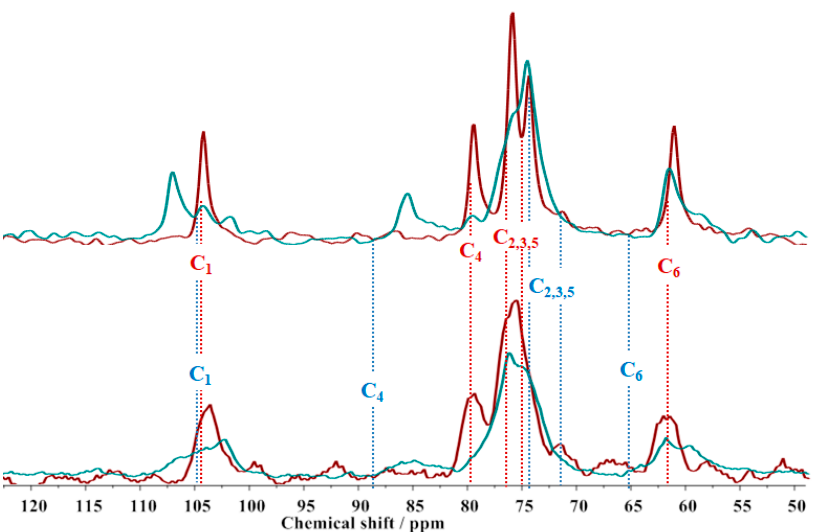
Figure 2. Polarization transfer solid-state nuclear magnetic resonance (PTssNMR) spectra for 10 wt % MCC dissolved in 8 wt % NaOH(aq.), with ( bottom ) and without ( top ) urea. The cross-polarization (CP, blue line) and the insensitive nuclei enhanced by the polarization transfer signal (INEPT, red line) spectra were acquired at 25 °C. The vertical lines represent the chemical shifts of native dry microcrystalline cellulose (MCC; blue dotted lines) [2] and dissolved cellulose [33] (red dotted lines). The MCC sample dissolved in an NaOH(aq.) solution, with and without urea, gives both CP (blue line) and INEPT (red line) signals. While the INEPT peaks of cellulose dissolved in NaOH(aq.) solution present chemical shifts that fit well with those assigned to the dissolved fraction of cellulose in ultra-centrifuged NaOH/D2O samples [33], the CP spectrum presents chemical shifts significantly different compared with solid MCC samples [2,9] (blue dotted vertical lines). A comparison of the